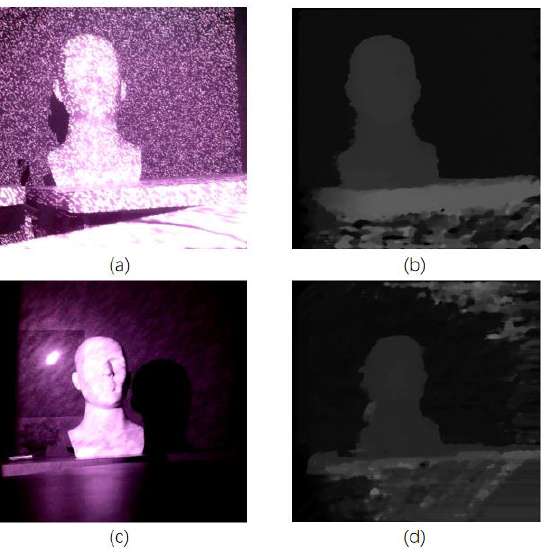
Figure 16. ( a – c ) image of real world obtained by camera; ( b ) Real time output disparity map of ( a ); ( d ) Real time output disparity map of ( c ).